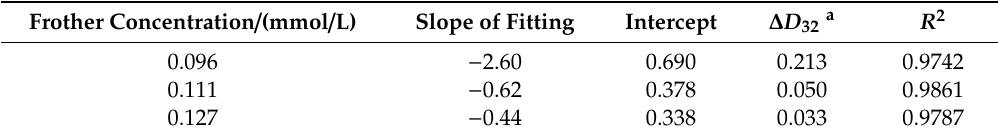
Figure 10. The rotating speed of the impeller ( n ) as a function of feeding pressure ( P ) Table 5. Information from bubble mean diameter–feeding pressure curve.